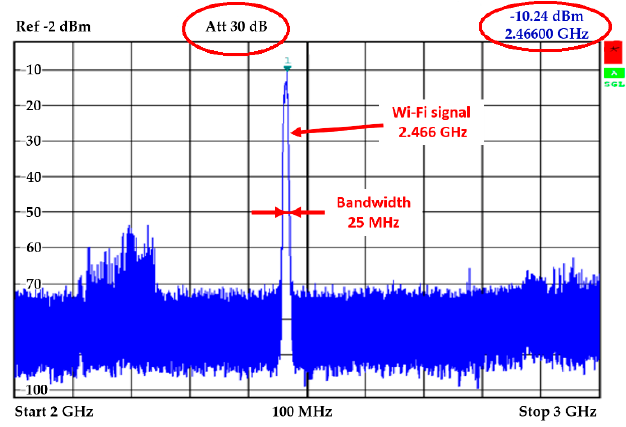
Figure 8. Analysis of the magnetron output signal.